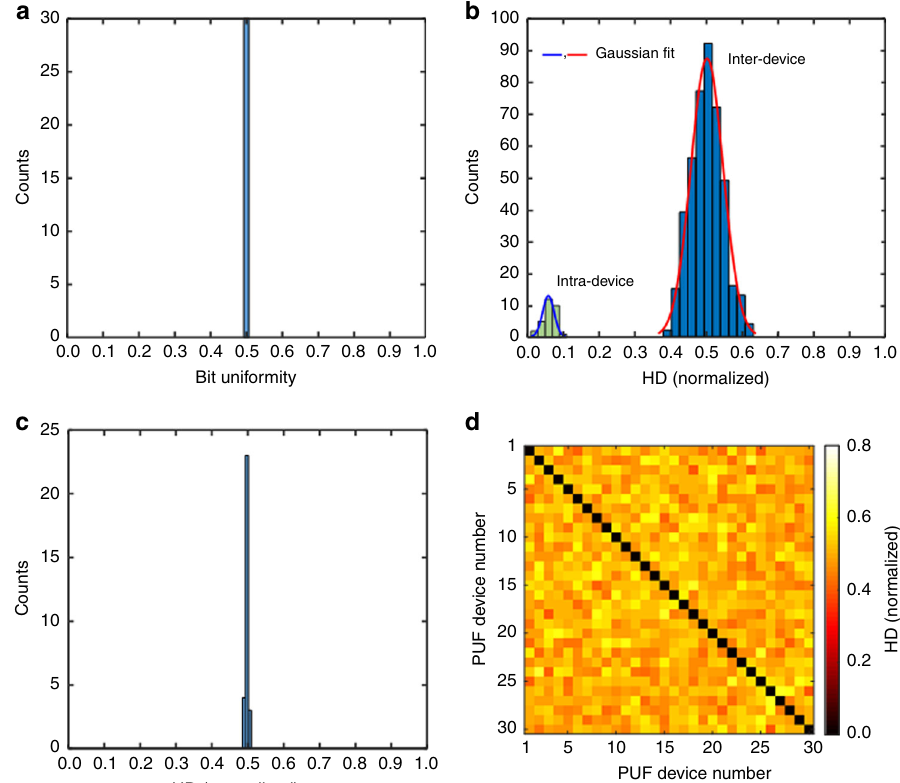
Fig. 6 Characterizations of the basic performance matrices of edible PUFs. a Bit uniformity calculated from 30 different PUFs shows the unbiased distribution of 0 and 1 states after von Neumann debiasing with a mean ( μ ) value of 0.5. b Inter-device Hamming Distance (HD) is used to characterize the device uniqueness of 30 different edible PUFs. A Gaussian fi t of the histogram returns μ = 0.5032 and a standard deviation (SD; σ ) of 0.0458 where the ð Þ ffiffiffiffi p e (cid:2) x (cid:2) μ ð Þ 2 = 2 σ 2 probability density of Gaussian distribution P x ð Þ ¼ 1 . The mean value is close to the ideal value of 0.5 with a narrow distribution. The σ 2 π mutually independent bits (degree of freedom or number of independent variables) of 120 ( ≈ 0.5032×(1 − 0.5032)/0.0458 2 ) result in an encoding capacity of 2 120 ( ≈ 1.3292×10 36 ). Intra-device HD is used to characterize the readout reproducibility (i.e., bit error rate) from 10 repeated challenge-response cycles (nine pairwise comparisons) in each PUF device among 30 different edible PUFs. A Gaussian fi t of the histogram returns μ = 0.0632 and σ = 0.0164. The clear separation between the intra-device and inter-device distributions indicates extremely low false positive and negative rates (Supplementary Fig. 14). c Comparisons among digitized keys from four responses in each PUF ensure the uniqueness of the responses in the PUF device. A mean HD is calculated in each PUF and 30 mean HDs from 30 different PUFs are plotted with μ = 0.4990 and σ = 0.0041. d Pairwise comparisons among 30 different edible PUFs. The HDs in the off-diagonal areas fl uctuate near the mean value of 0.5032. The source data are provided as a Source Data fi